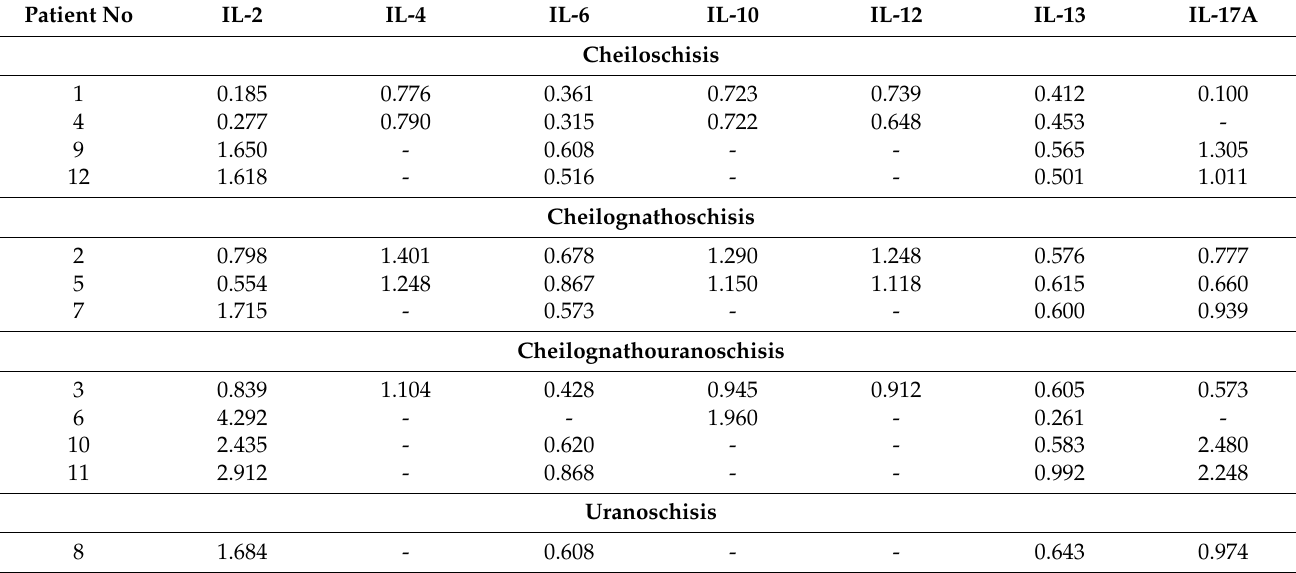
Table 3. Concentration of interleukins in individual patients measured in